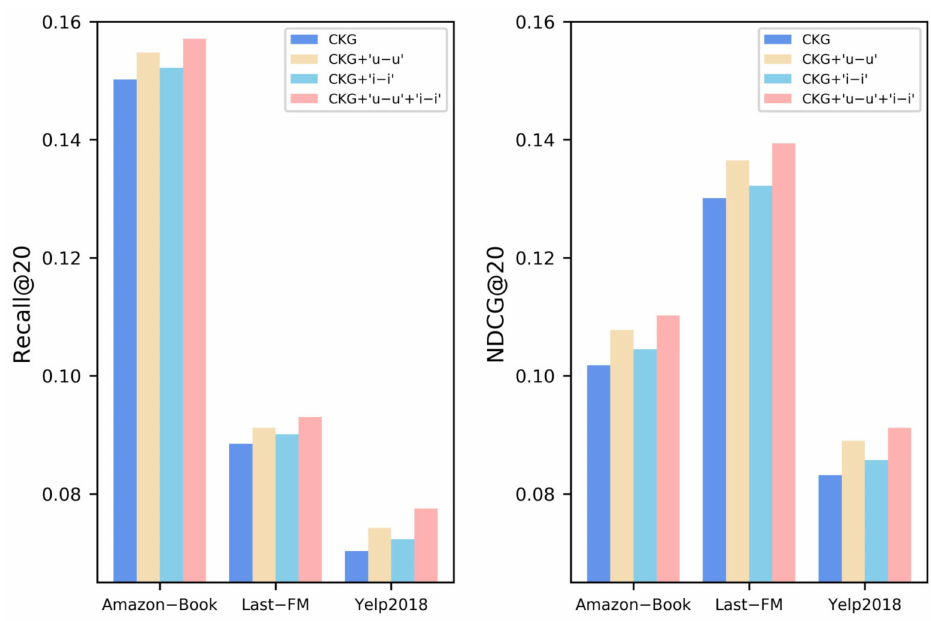
Figure 7. Experimental analysis of improved ablation of CKG.